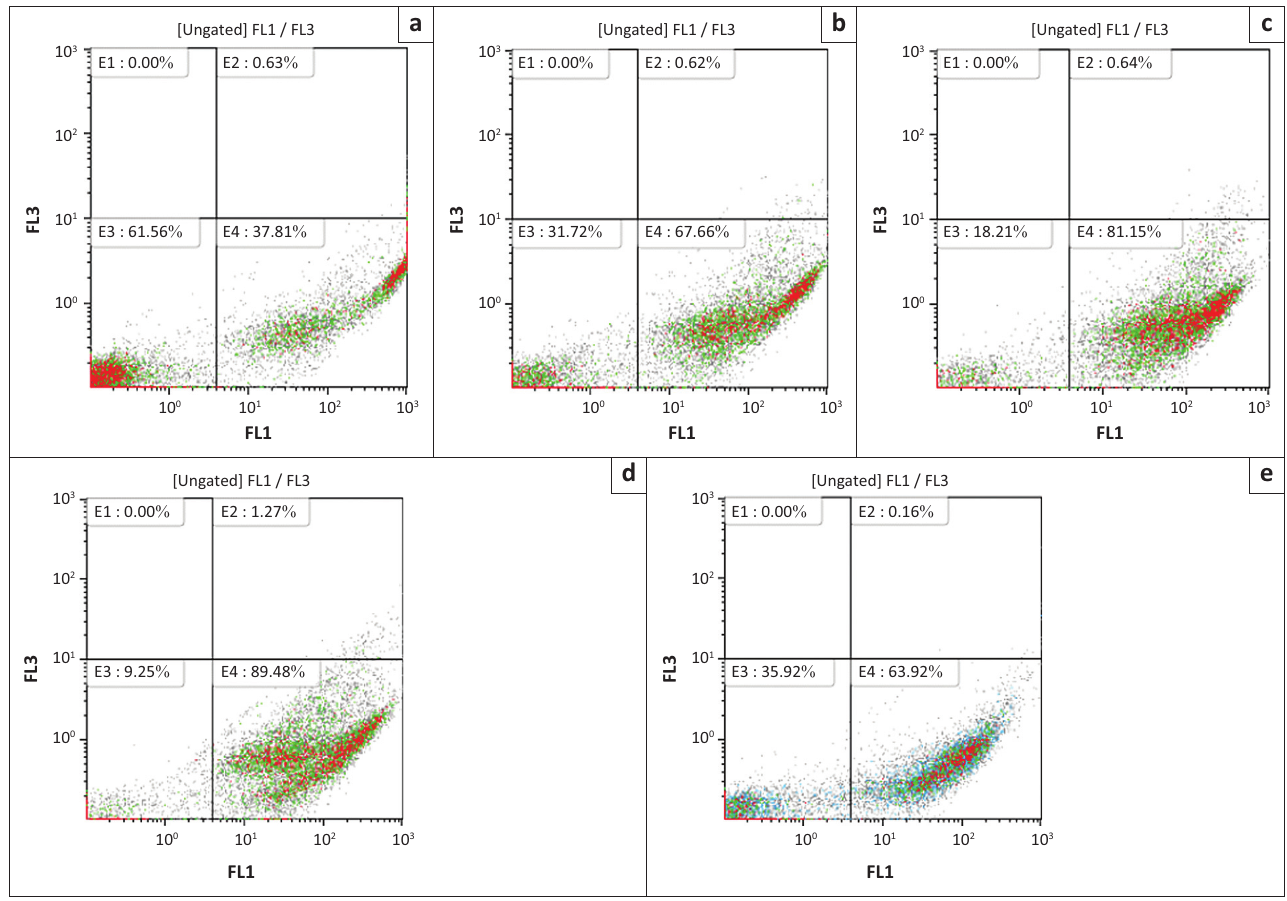
FIGURE 3: Annexin V activity (flow cytometry) following exposure of C2C12 myoblasts to geigerin (2.0 mM, 2.5 mM and 5.0 mM), media only (control) and staurosporine (positive control) for 24 h. (a) Control, (b) Geigerin 2.0 mM, (c) Geigerin 2.5 mM, (d) Geigerin 5.0 mM and (e) Straurosporine 1 µ